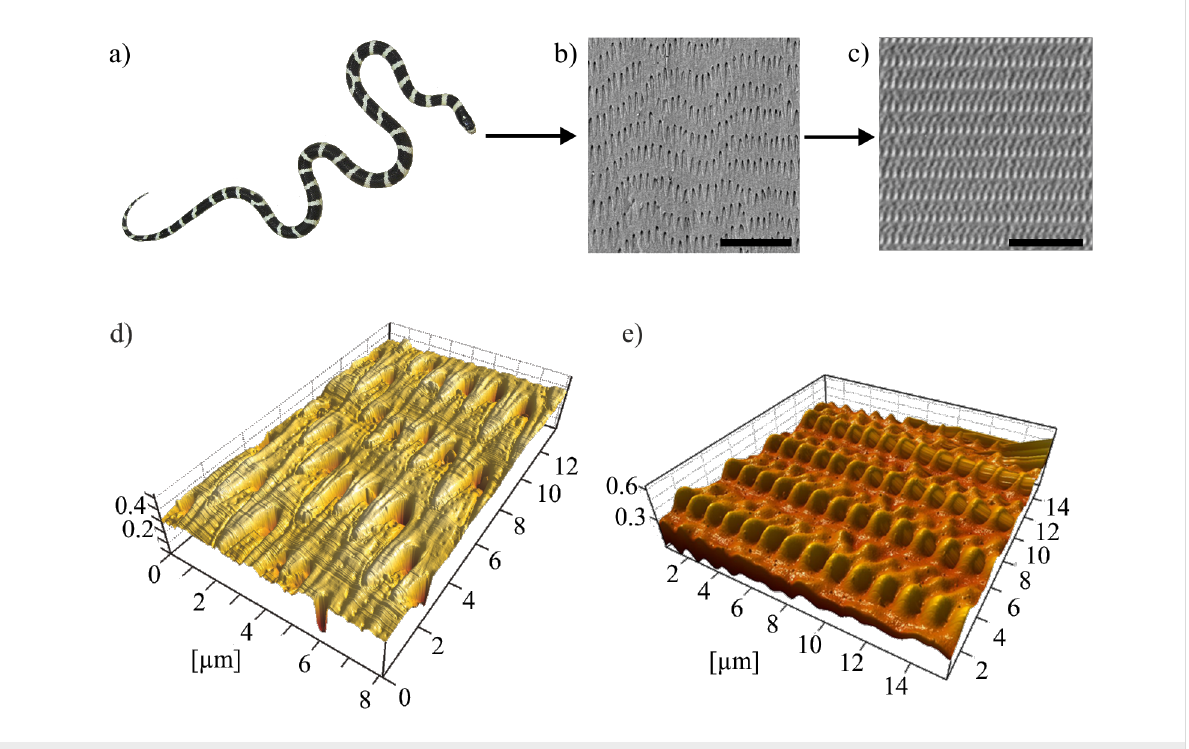
Figure 1: From snake skin to SIMPS. a) Photograph of L. g. californiae , the California King Snake; b) SEM micrograph of a ventral scale of L. g. californiae ; c) SEM micrograph of the snake-inspired microstructured polymer surface – SIMPS. Scale bars: 10 µm. 3-dimensional image of d) snake skin from L. g. californiae and e) SIMPS based on AFM